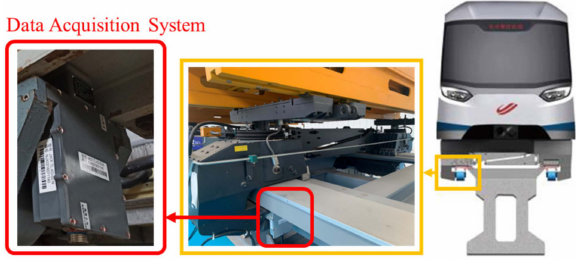
Figure 6. Schematic diagram of maglev data system.